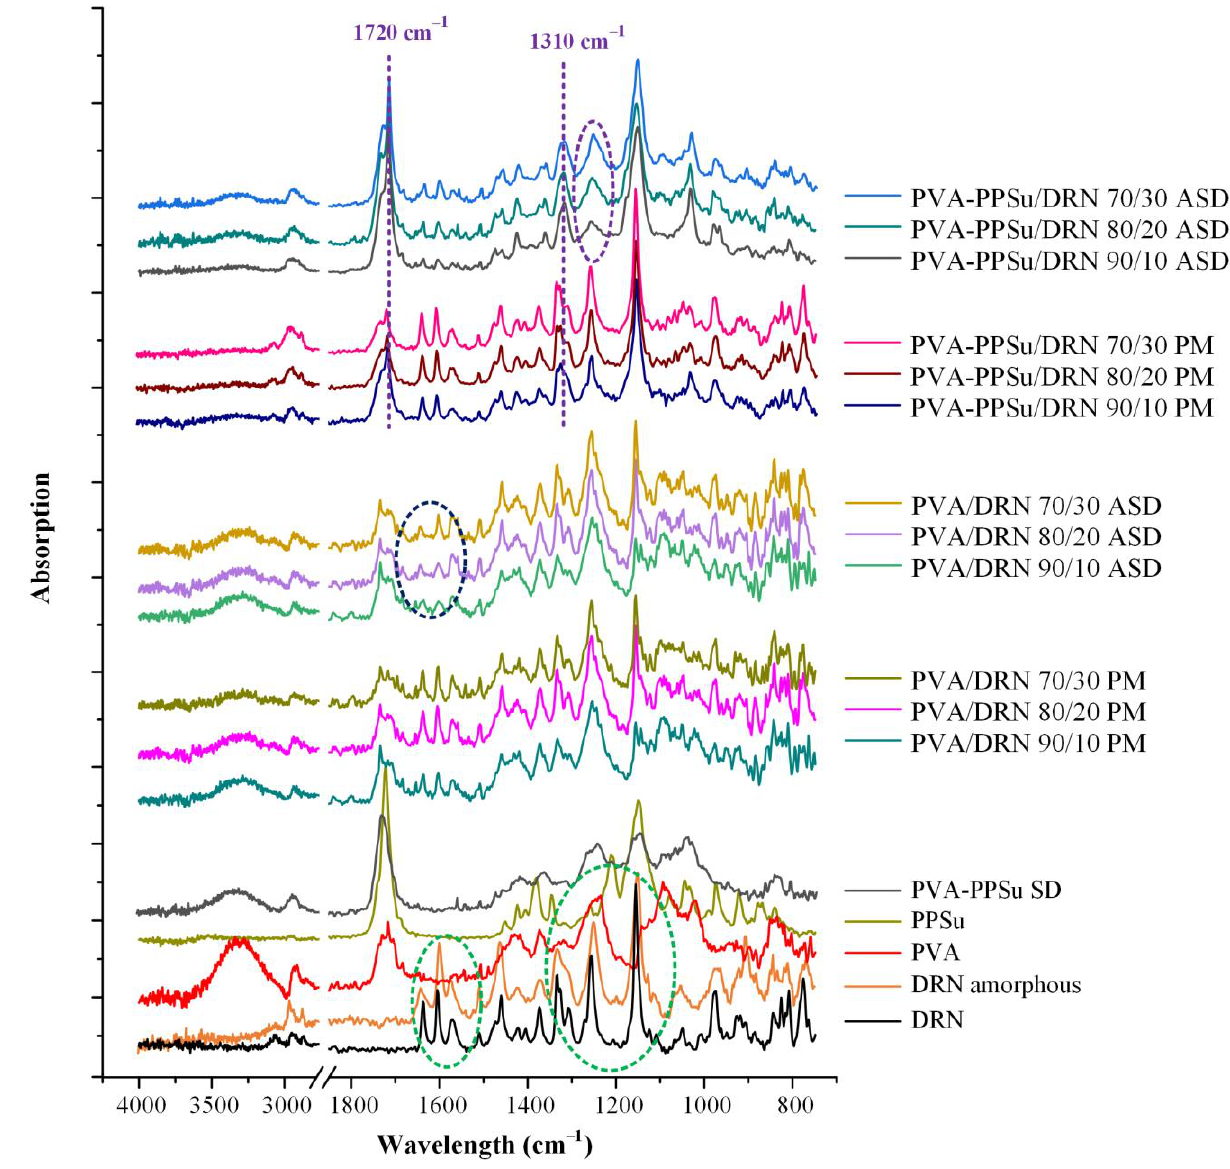
Figure 11. ATR − FTIR spectra of the initial raw materials, the pure amorphous DRN, the neat PVA − PPSu matrix after melt-quench cooling (PVA − PPSu SD) and the binary (PVA/DRN) and ternary (PVA − PPSu/DRN) ASDs with their PMs at several weight ratios (green dashed circles highlight the differences between the amorphous and the crystalline DRN spectra, dark blue dashed circles highlight the presence of amorphous DRN in the PVA/DRN ASD spectra, while purple dashed lines and circles highlight the differences among the PVA − PPSu/DRN ASDs and PMs).